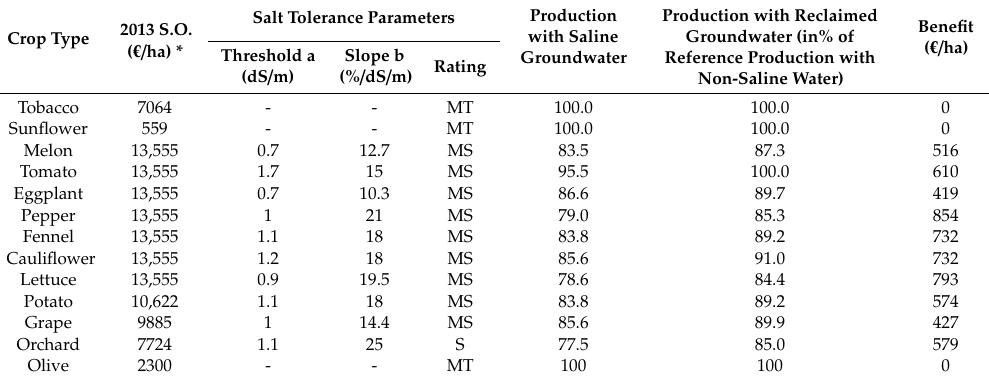
Table 4. Economic and salt tolerance parameters to assess benefits due to reduced saline concentration in irrigation water. MT, MS and S respectively indicate medium tolerance, medium sensitivity and sensitivity to salt concentration. Values in the third and second last column are obtained from the Maas-Ho ff man relationship for saline concentrations of 2.0 and 1.7 dS / m respectively. Benefits in the last column are obtained multiplying the standard output (second column) by the di ff erence between second last and third last